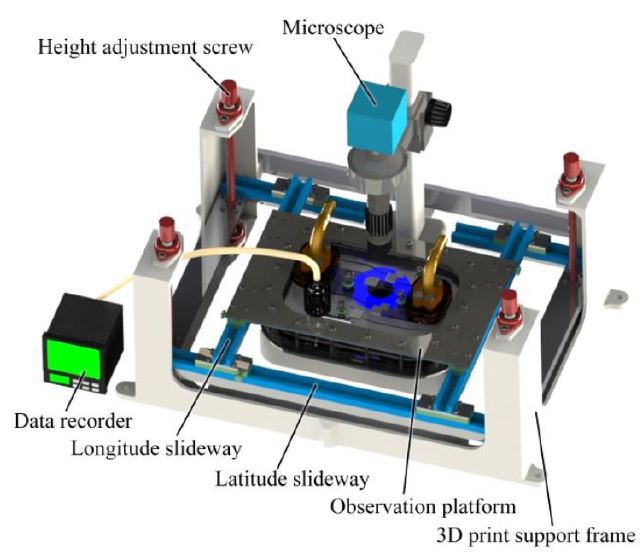
Figure 3. Valve orifice temperature measurement device.